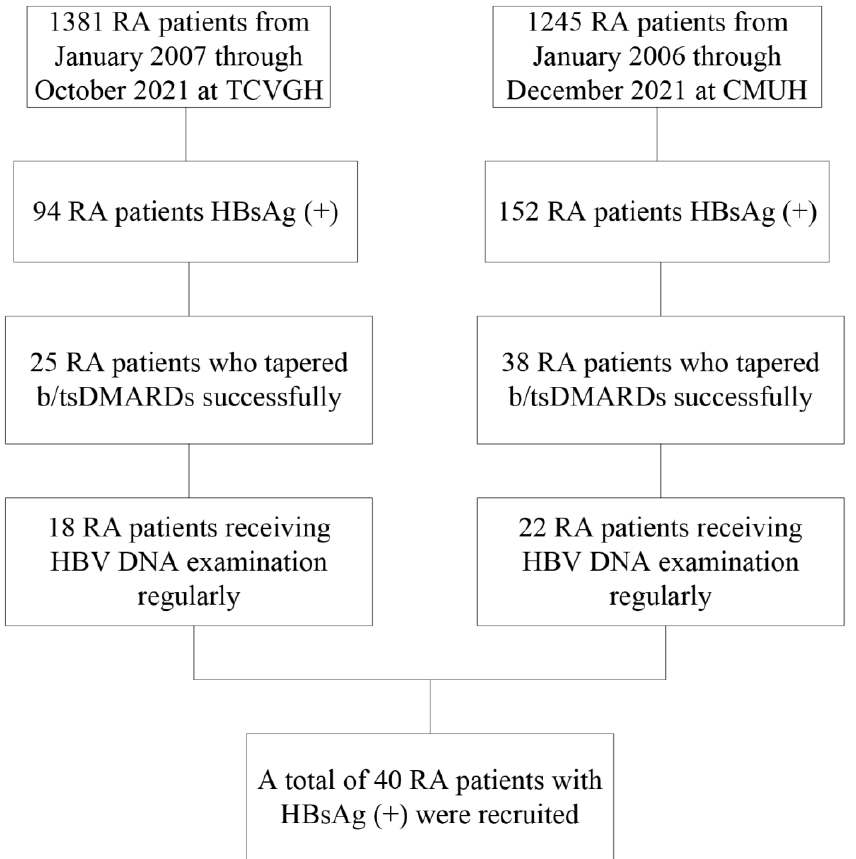
Figure 1. Study flow chart. b/tsDMARDs, biologic/targeted synthetic disease-modifying antirheumatic drugs; CMUH, China Medical University Hospital; DNA, deoxyribonucleic acid; HBV, hepatitis B virus; HBsAg, hepatitis B virus surface antigen; RA, rheumatoid arthritis; TCVGH, Taichung Veterans General Hospital. Table 1. Characteristics of RA patients before the use of